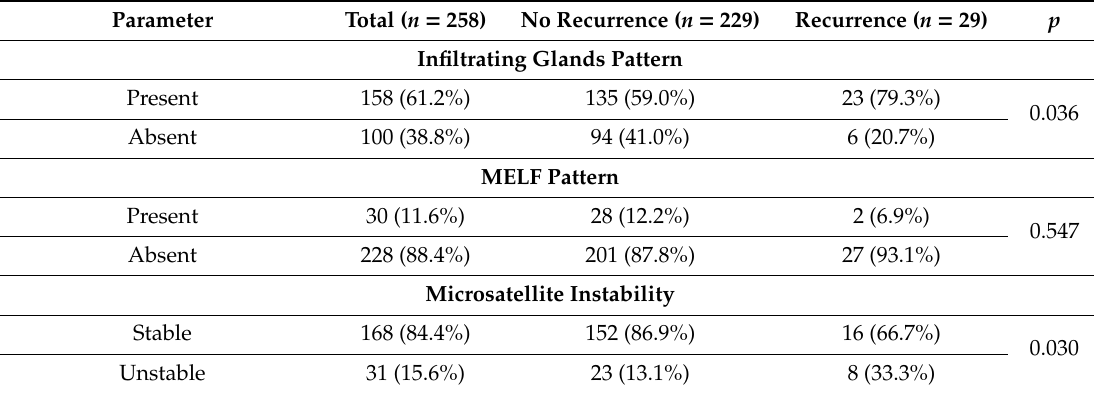
FIGO, International Federation of Obstetrics and Gynaecology; MELF, microcystic, elongated and fragmented glands; A. malignum, adenoma malignum.